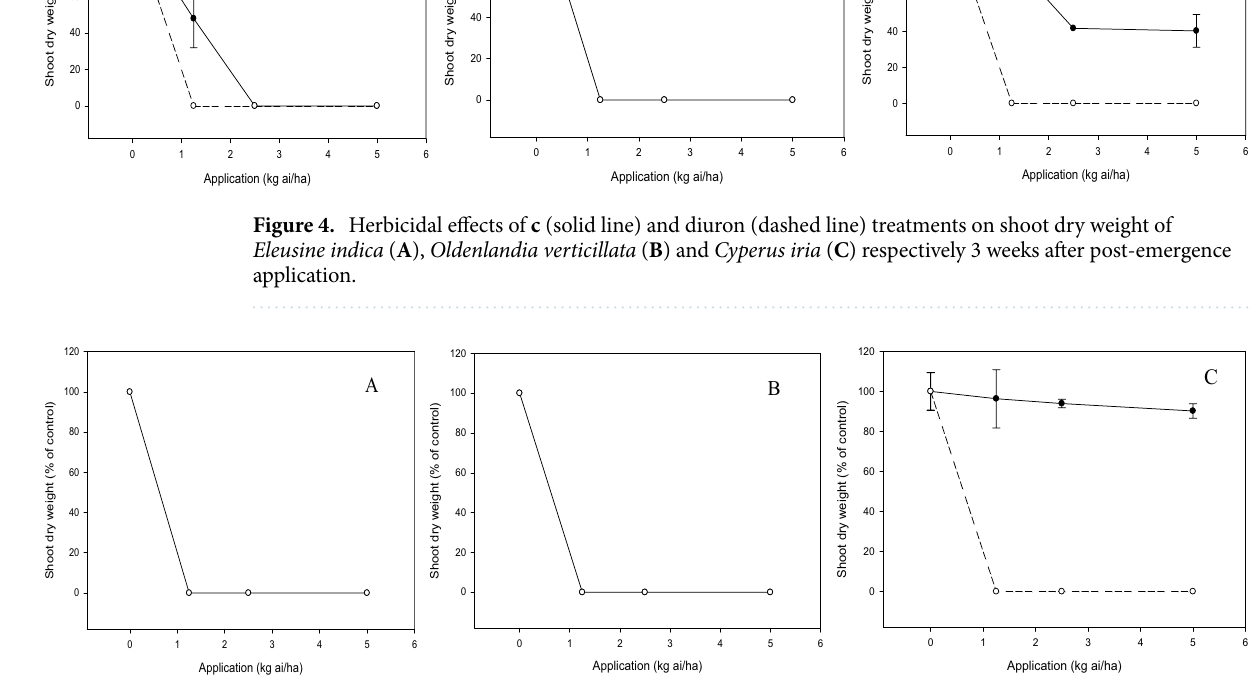
Figure 5. Phytotoxic effects of c (solid line) and diuron (dashed line) treatments on shoot dry weight of Brassica rapa ( A ), Zea mays ( B ) and Oryza sativa ( C ) respectively 3 weeks after post-emergence